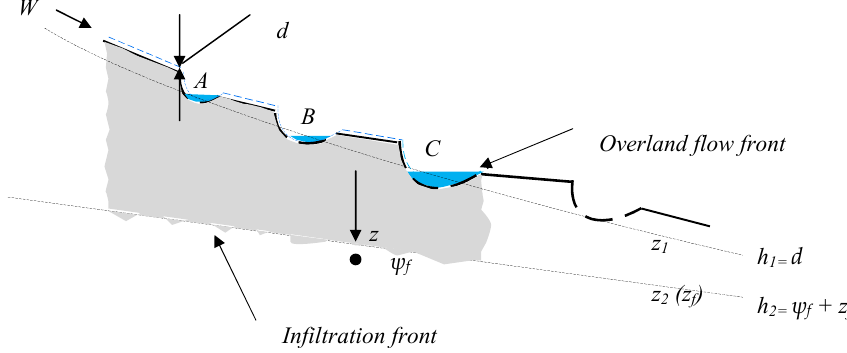
APPENDIX I SATURATED-UNSATURATED INFILTRATION Consider a soil profile at an experimental plot surface (Figure I-1) receiving a continuous water inflow ( W ). A water front at the soil surface limits a soil area where simultaneous saturated infiltration occurs at ponded areas, and un-saturated infiltration 5